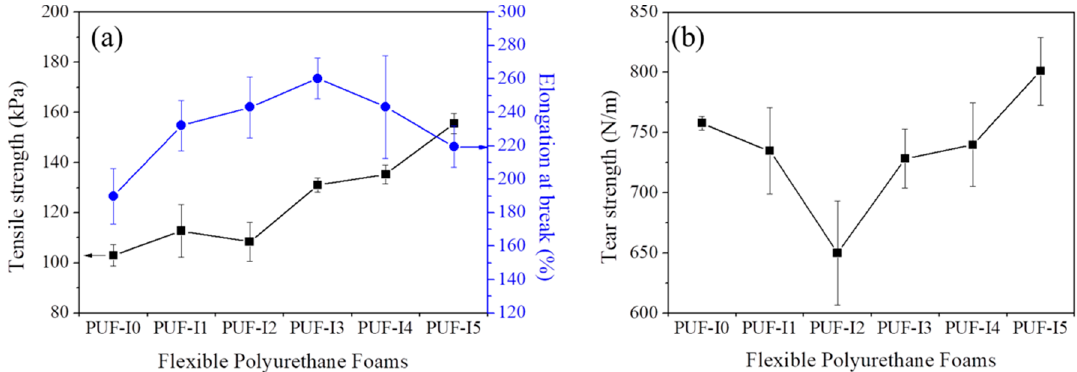
Figure 3. ( a ) Tensile strength and elongation at break; and ( b ) tear strength of the various FPUFs.